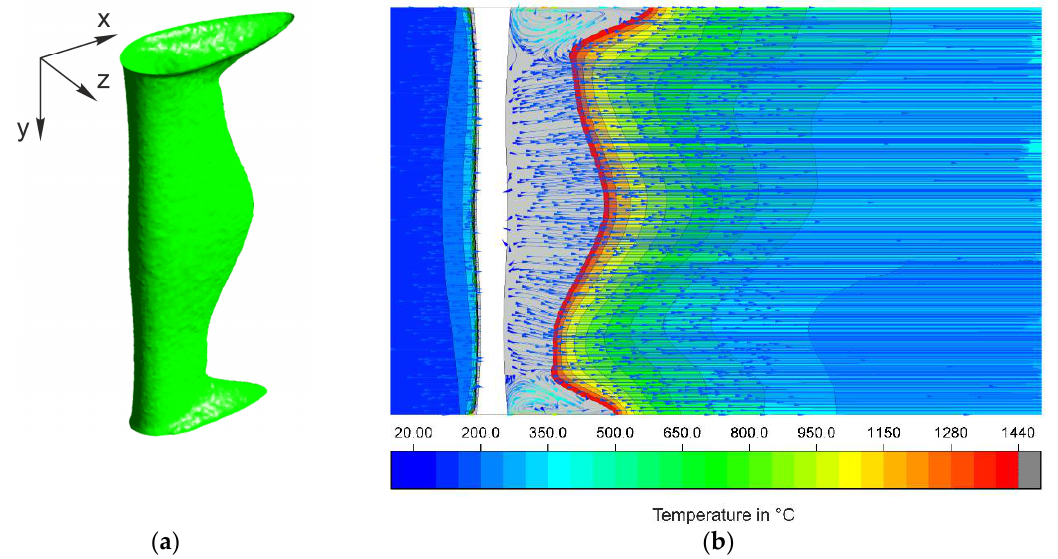
Figure 7. ( a ) The weld pool geometry defined by the liquidus temperature. ( b ) Temperature field and velocity streamlines in the symmetry plane of the model.